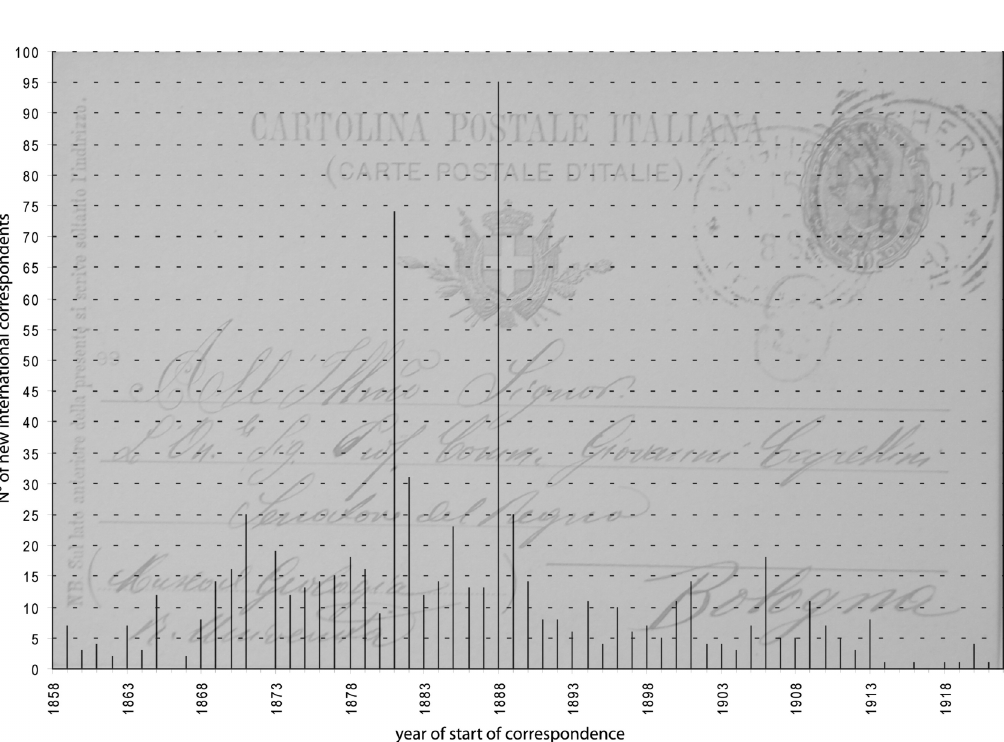
Fig. 4. Chart of the number of new international correspondents correlated with the start of the